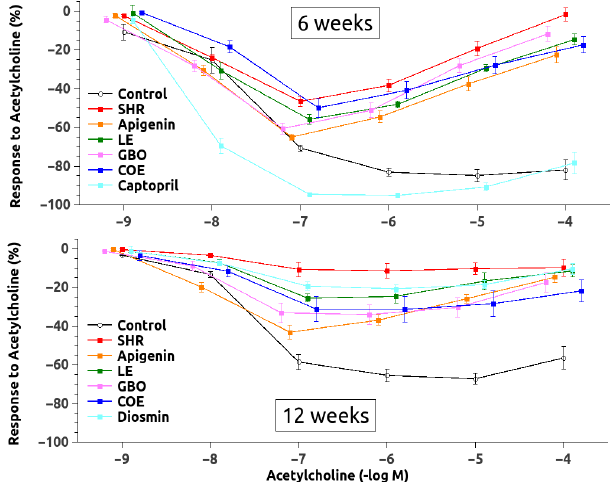
Figure 3. Vasodilatory response to acetylcholine in phenylephrine-preconstricted aortic rings. Abbreviations: SHR (spontaneously hypertensive rats), LE (lemon extract), GBO (grapefruit + bitter orange extract), and COE (cocoa extract).